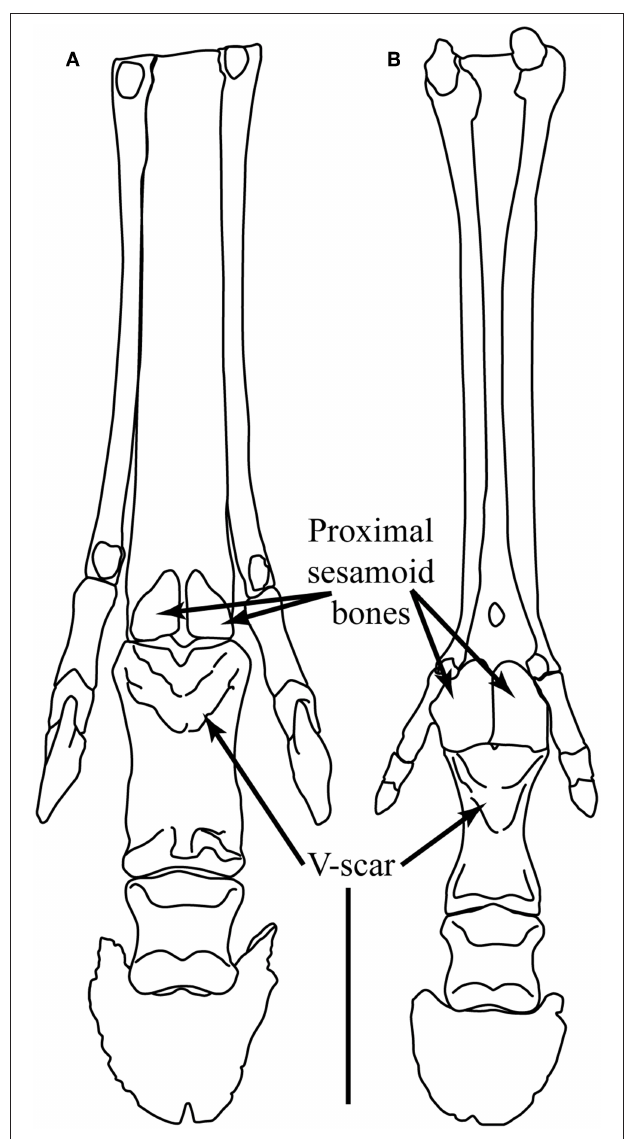
FIGURE 5 | Plantar view of the left foot of (A) Hippotherium primigenium and (B) Pliohippus pernix . Hippotherium is from the late Miocene of Höwenegg (Germany), and the illustration is modified from Figures 6.23.2 and 6.31.1 in Bernor et al. (1997). Pliohippus is based on F:AM 60803 from the early late Miocene (early Clarendonian) of Nebraska (June Quarry, Burge Member of the Valentine Formation) (photographs taken by CMJ, third phalanx mirror-imaged). Scale bar = 5 cm. Illustration by James G.